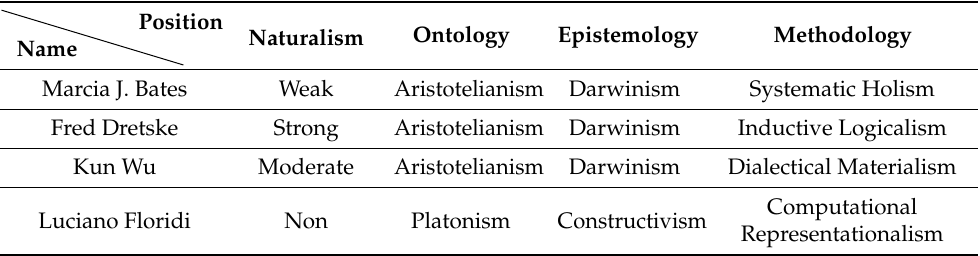
Table 1. Position comparisons in the information